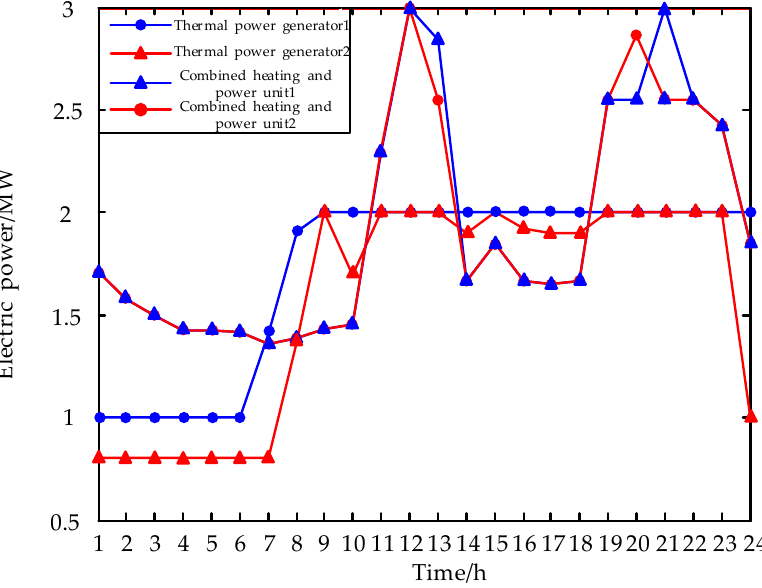
Figure 5. Power output scheduling curve of micro source.